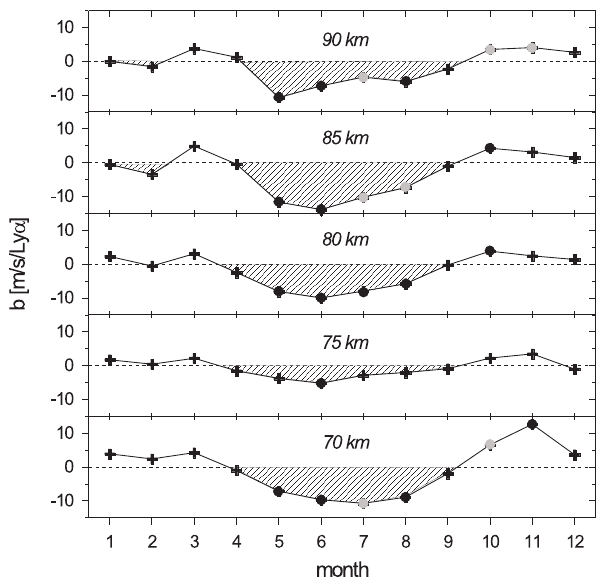
Fig. 5. Seasonal variation of the partial regression coefficient b (see Eq. 1) between the mesospheric zonal wind at Juliusruh and the solar activity for different heights (significance level χ marked by black dots ( χ ≥ 95%), grey dots ( χ ≥ 90%), and crosses ( χ< 90%)).